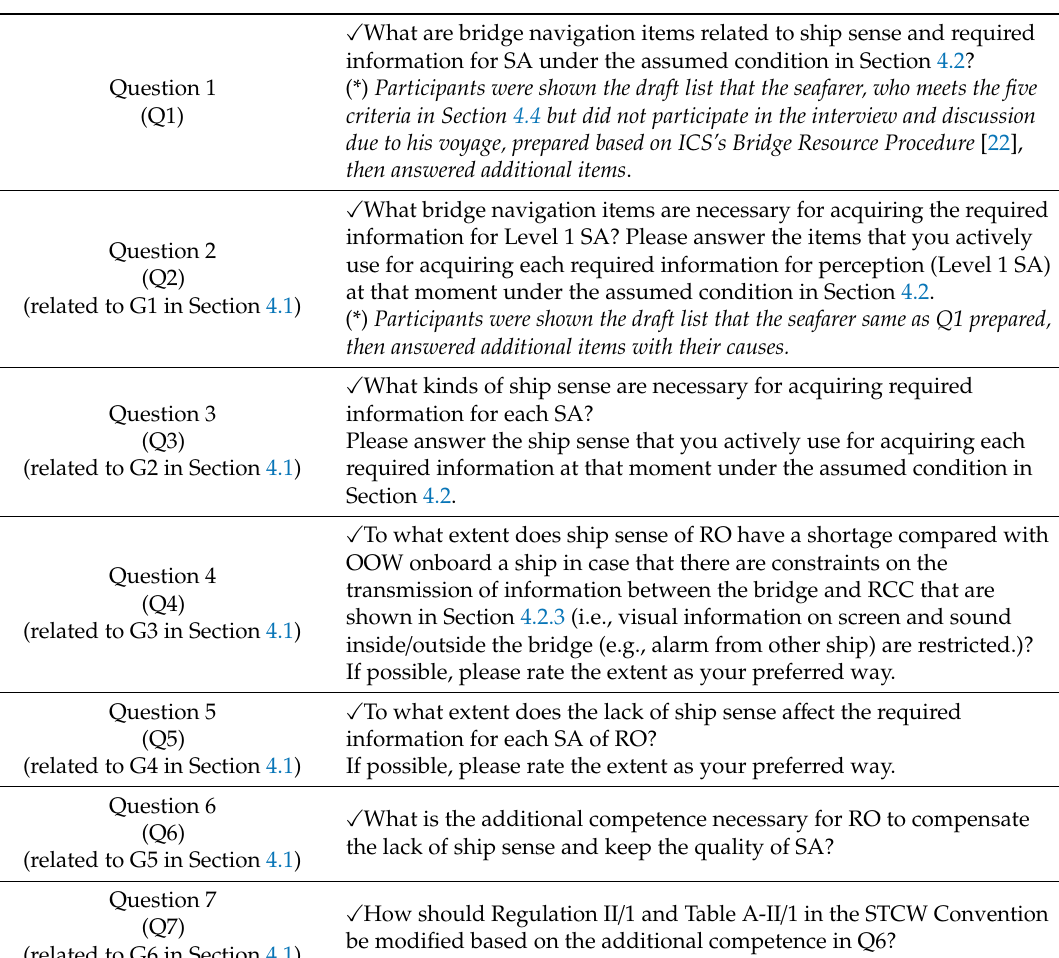
Table 2. Questions to